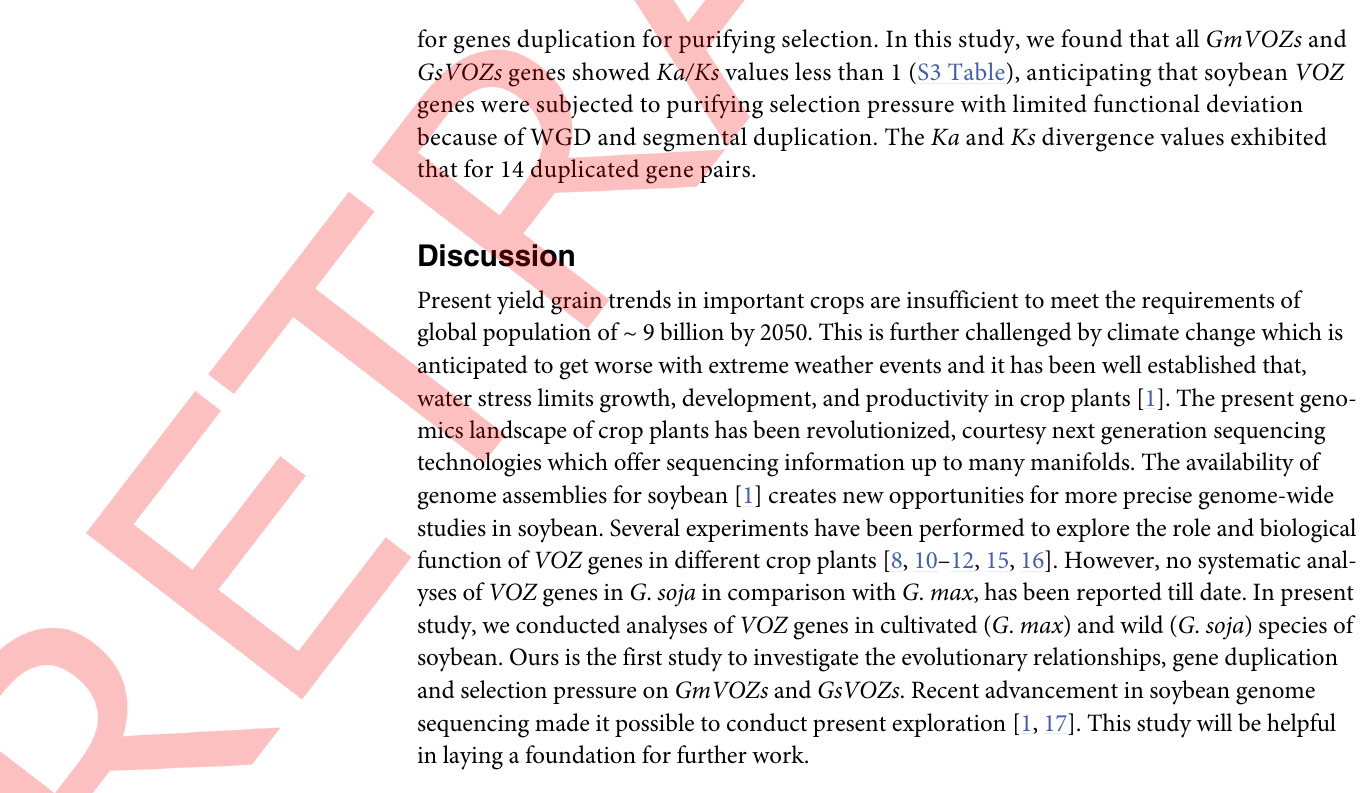
Fig 8. Gene duplication among GmVOZs and GsVOZs gene. Blue line indicates orthologous/paralogous pairs. Gm01 to Gm20 indicates the chromosomes of G . max and Gs01 to Gs20 represent the chromosome of G . soja .